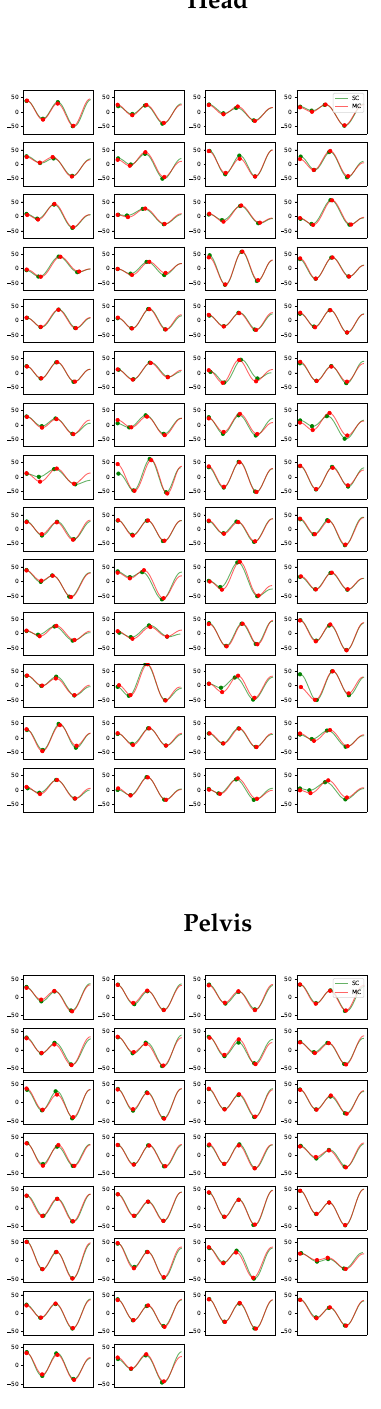
Figure A22. Vertical displacement signals per stride for the head and pelvis for horse 23. Each subplot contains the matched stride segments for the single-camera markerless system (SC) in green and the multi-camera marker-based system (MC) in red. The y-axis shows the vertical displacement in millimeters. The four dots on each curve indicate the positions of the two peaks and two valleys extracted using the approach in Section